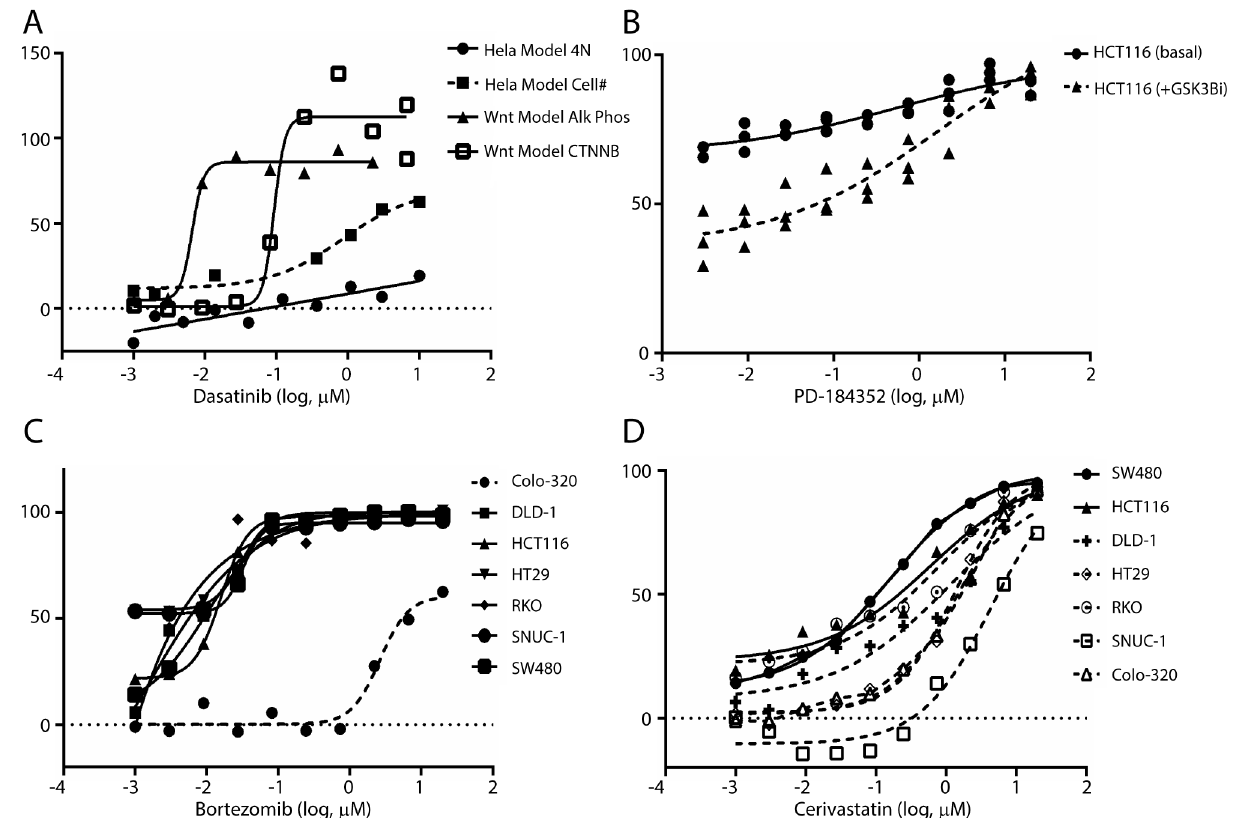
Fig 2. Activities for selected approved drugs versus specified assay modules. A response of 0% is equivalent to DMSO control, while a 100% response corresponds to the appropriate positive control for the assay (methods). A. The activity of the multikinase inhibitor dasatinib within the Wnt potentiation module. Included are the outcomes in a multilineage potential C2C12 cell line as judged by β -catenin translocation ( □ ) and alkaline phosphatase activity ( ▲ ); selectivity of the Wnt response vs. cell cycle effects is assessed by comparison to % inhibition of cell count ( & ) and % stimulation of 4N DNA content ( ● ) as determined via propidium iodide staining in HeLa cells. B. Inhibition of cellular ATP by the MEK inhibitor PD-184352 in HCT116 cells alone ( ● ) or following pretreatment with a GSK3 β inhibitor ( ▲ ). C. Inhibition of cellular ATP by the proteasome inhibitor bortezomib in the KRAS assay modules including Colo320 (- ● -), DLD-1 ( & ), HCT116 ( ▲ ), HT-29 ( ▼ ), RKO ( ♦ ), SNU-C1 ( ● ), and SW480 ( & ). D. Inhibition of cellular ATP by simvastatin, cerivastatin and fluvastatin in the KRAS assay modules including the KRAS-mutant lines SW480 ( ● ), HCT116 ( ▲ ) and DLD-1 (+) vs. the KRAS wild type lines HT-29 ( ^ ), RHO ( (cid:4) ), SNU-C1 ( □ ) and Colo320 ( Δ